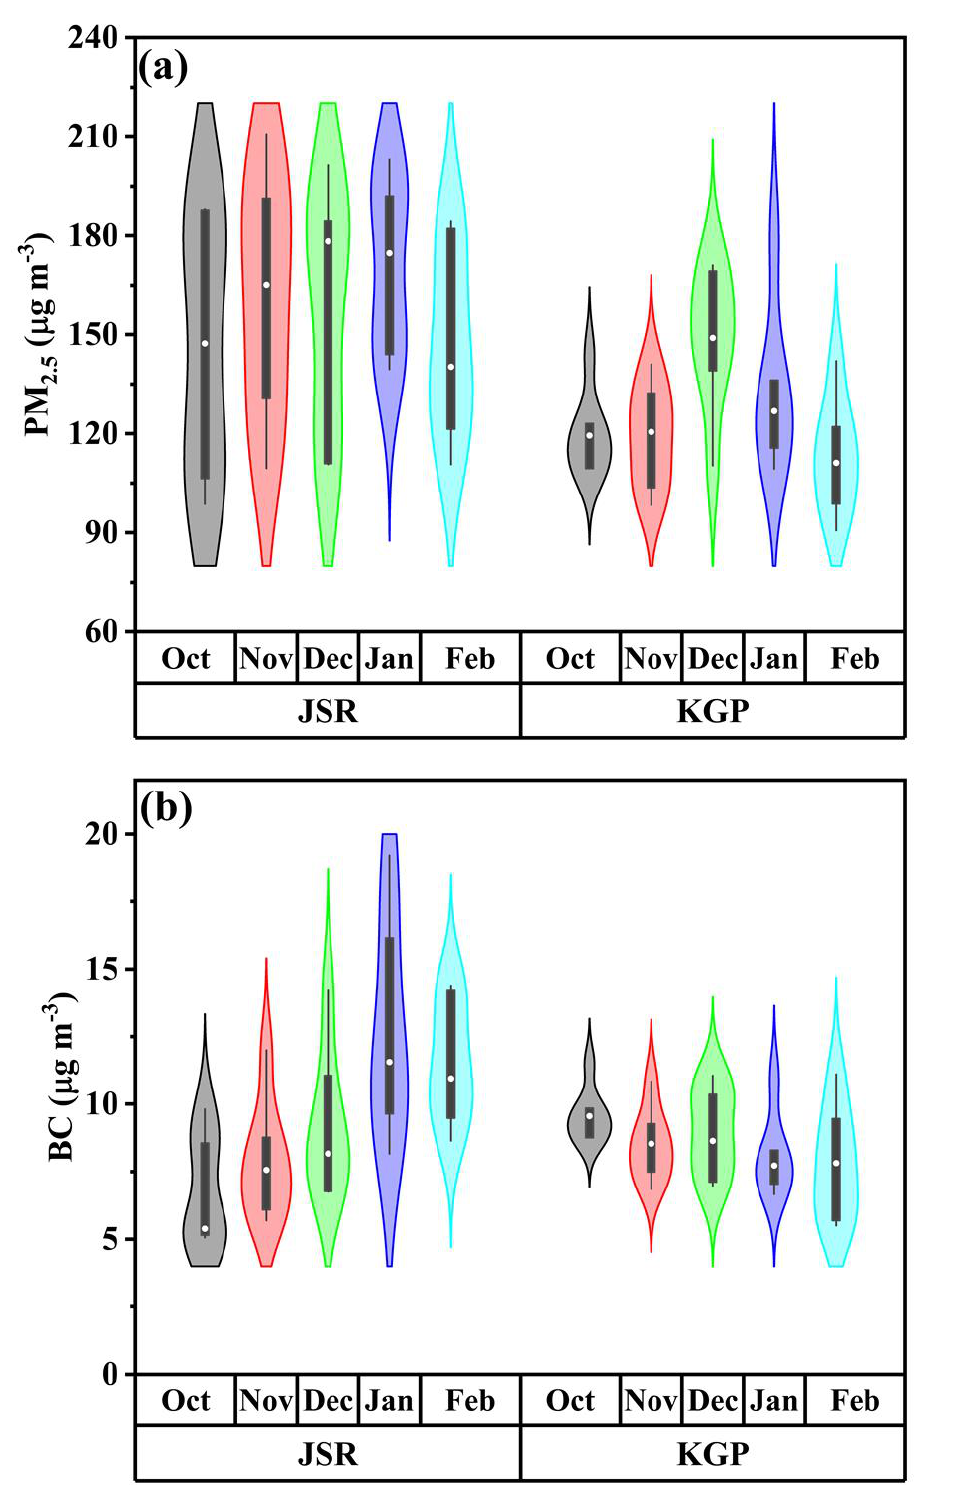
Figure 2. Monthly (average ± standard deviation) mass concentrations of ( a ) BC and ( b ) PM 2.5 from October 2019 to February 2020 at JSR and KGP observation sites. The average BC mass concentrations were recorded as 9.46 ± 3.35 μg m −3 (5.06 – 19.22 µg m −3 ) and 8.58 ± 1.60 μg m −3 (5.50 – 11.52 µg m −3 ) at JSR and KGP, respectively. The monthly mean (± standard deviation) variation of BC concentration from October 2019 to February 2020 is shown in Figure 2b. In JSR city, the monthly BC concentrations were 6.7 ± 2.05, 7.8 ± 2.10, 9.1 ± 2.67, 12.7 ± 4.1, and 11.5 ± 2.2 µg m −3 , while in KGP, the BC mass